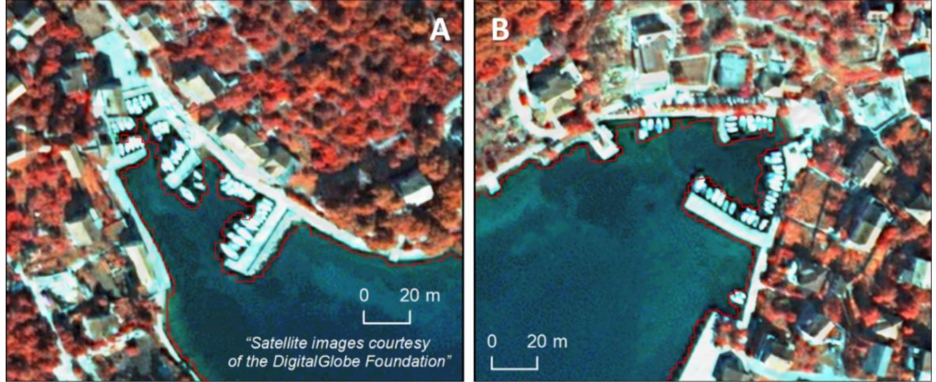
Figure 15. Overestimation of the extracted coastline caused by spectral disinformation affected by small fishing boats within Veli Iž ( A ) and Vela Rava ( B )